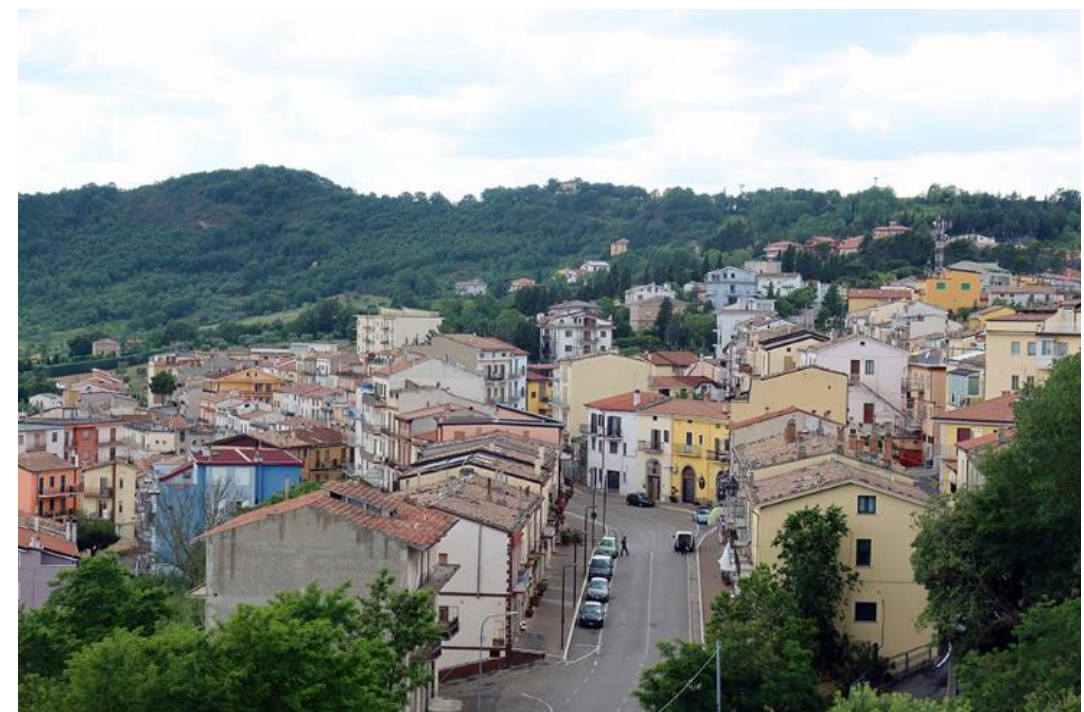
Figure 113. Calitri: panoramic view of new buildings (photos by [35,36]).